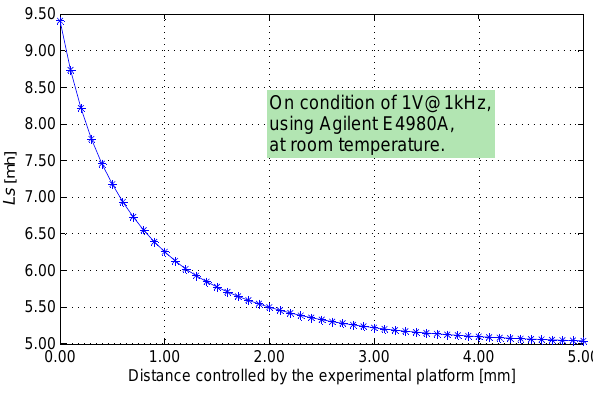
Figure 15. Distance vs. L S .